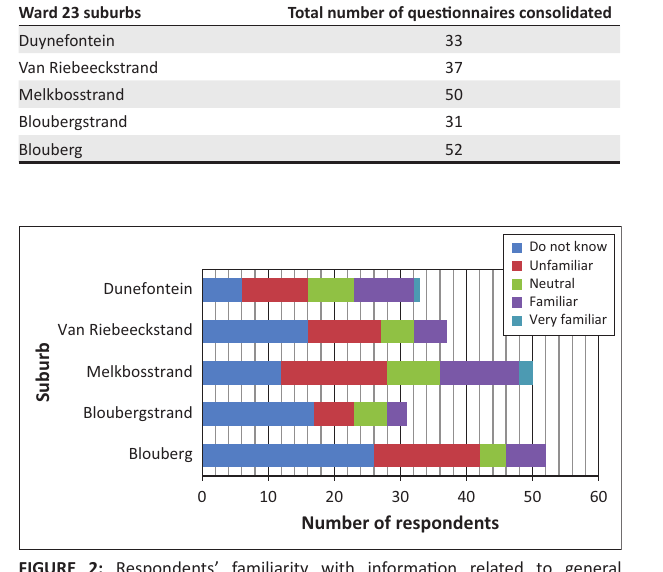
FIGURE 2: Respondents’ familiarity with information related to general emergencies.